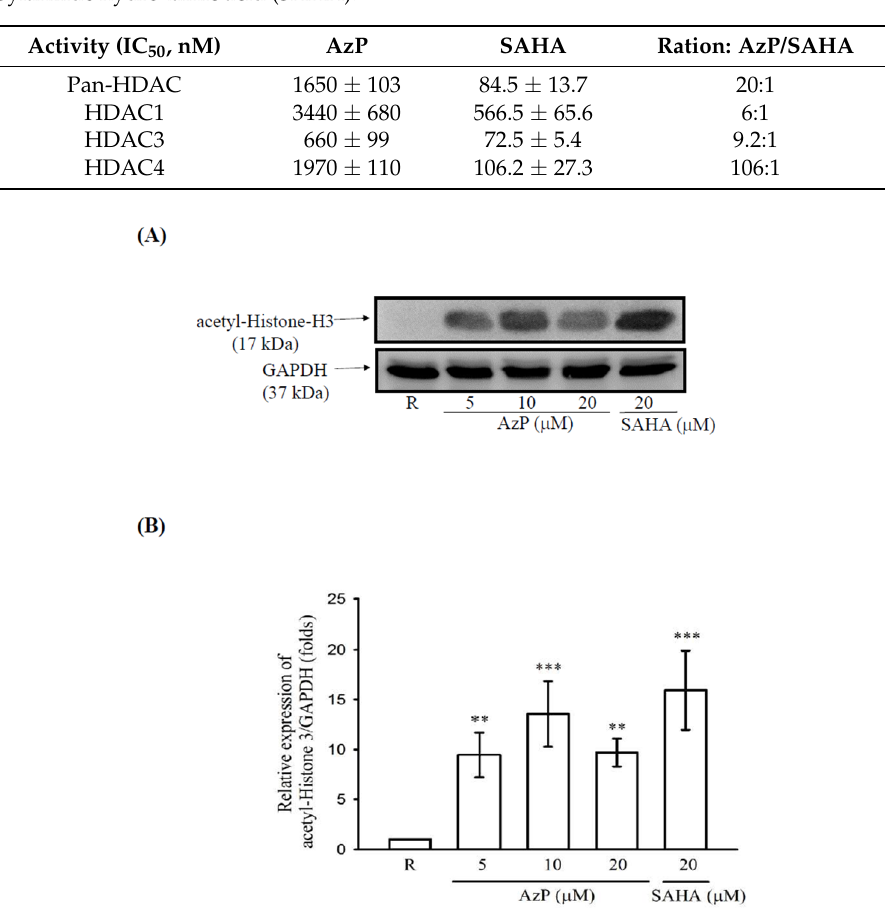
Figure 3. In vitro histone deacetylase (HDAC) activity. ( A ) The epithelial intestinal cell line IEC-6 cells (1 × 10 6 cells/mL) were dispensed on 6 cm dishes and treated with the indicated concentrations of AzP (5, 10 and 20 µ M) or suberoylanilide hydroxamic acid (SAHA) (20 µ M) for 24 h. Cell lysates were used for acetyl-histone H3 protein expression by Western blot. Data are expressed as means ± SD from 3 independent experiments. *** p < 0.001 as compared with the resting and ** p < 0.01 as compared with the resting ( B ).